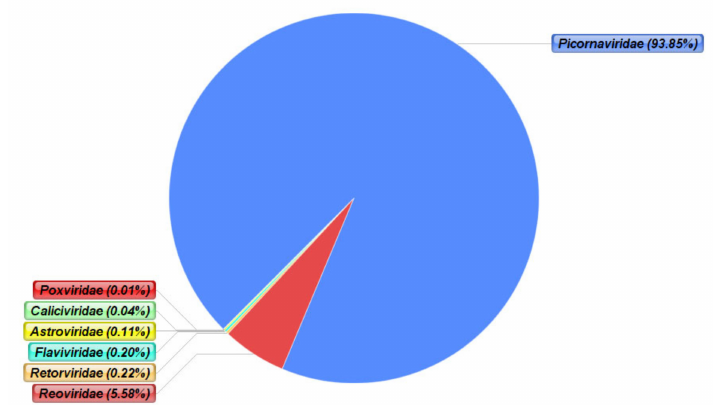
Figure 3. Percentages of contigs of the RNA viruses from all twelve faecal samples classified into their respective viral families. Over 90% of the viral contigs were classified under the Picornaviridae family. Other families present were Reoviridae , Retroviridae , Flaviridae , Astroviridae , Caliciviridae , and Poxviridae